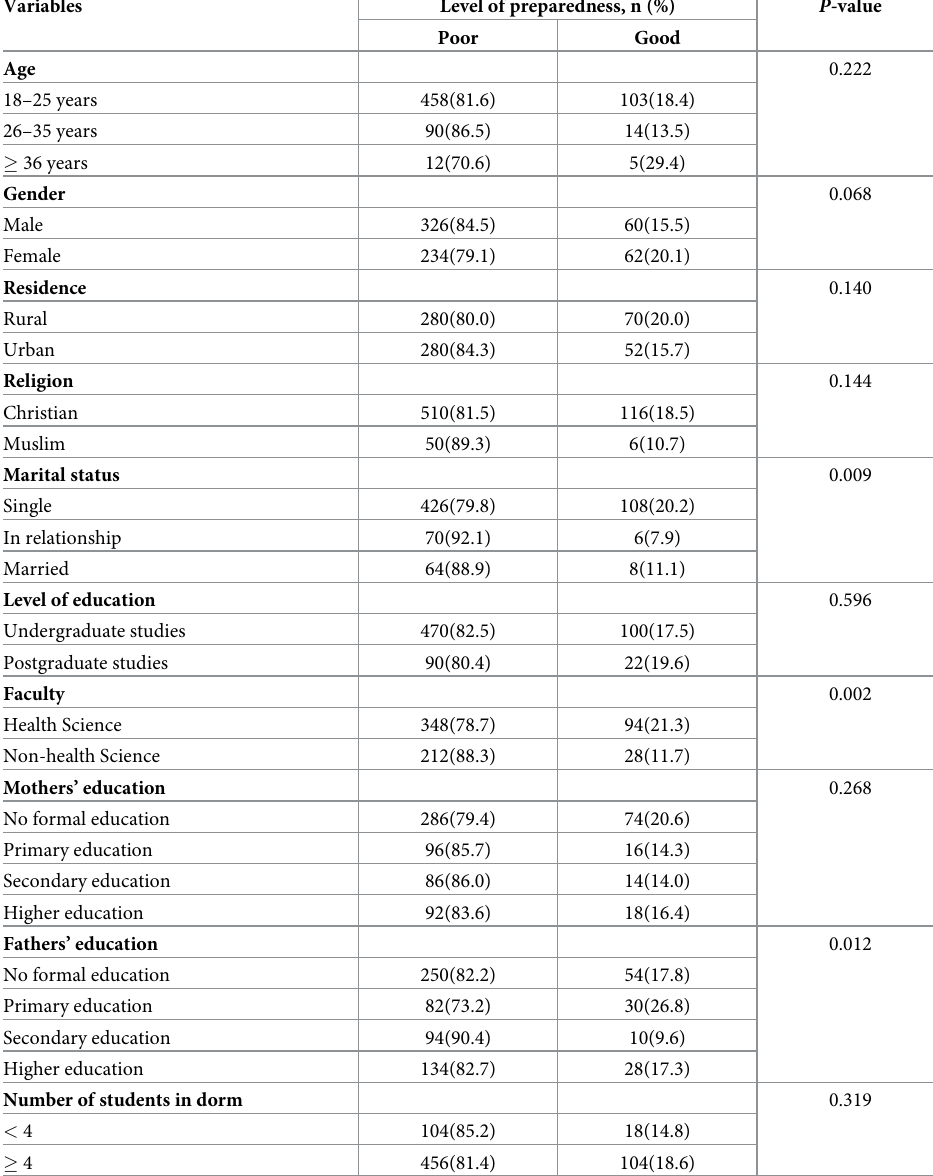
Table 1. Distribution of sociodemographic characteristics by level of preparedness in DBU, 2020.